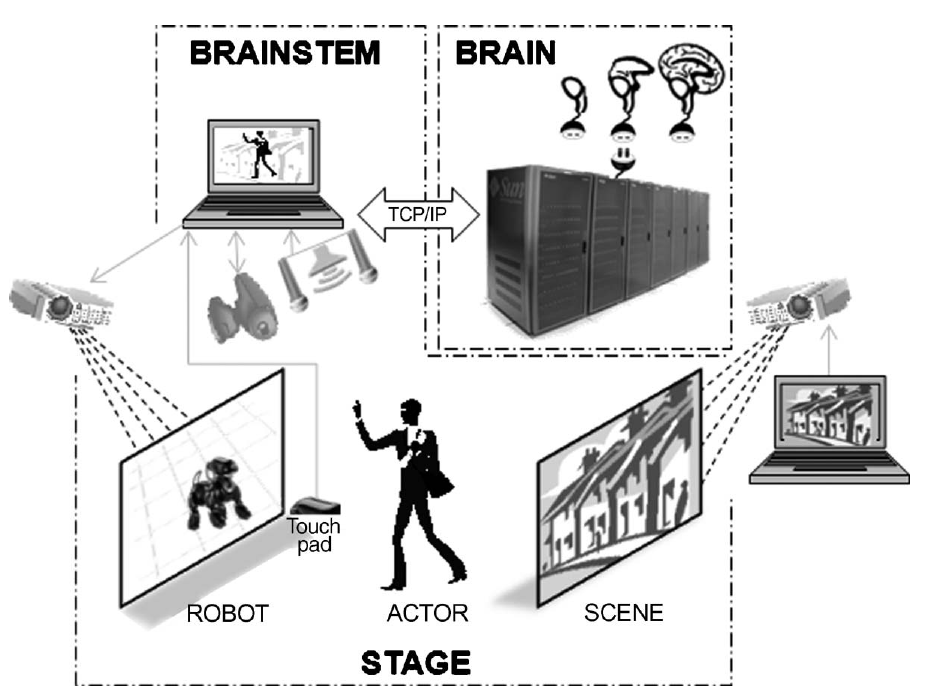
Figure 1. Schematic cartoon of a fully implemented virtual neurorobotic (VNR) system . VNR substitutes a pseudo-3D screen projection for the physical robot, which participates in real-time interplay with the human actor. The robot’s eyes (pan-tilt-zoom camera) and ears (monaural or spaced stereo microphones) capture the actor’s movements and voice in the context of the background scene, which is projected independently (and may contain moving elements, including other animals or actors). The BRAINSTEM is a multiprocessor computer (running threads) that synchronously (1) captures and preprocesses video images, sound, and touch, (2) converts preprocessed sensory images into probabilities of spiking for each primary neocortical region, (3) uploads the spike probability vectors to the BRAIN simulator, (4) accepts, from the BRAIN simulator motor neuron region, output spike density vectors and triggers corresponding dominant motor sequences (e.g., sitting, lying, barking, walking) via the robotic simulator program (Webots/URBI), which makes the corresponding changes in behavior of the projected robot (and incorporates internal sensation such as proprioception and balance). The BRAIN simulator is a neuromorphic modeling program running on a supercomputer, executing a pre-specified spiking brain architecture, which can adapt as a result of learning (using reward stimuli offered by the ACTOR’s voice or stroking of the touch pad). Based on successful performance, researchers iteratively “plug in” alternative or more complex brain